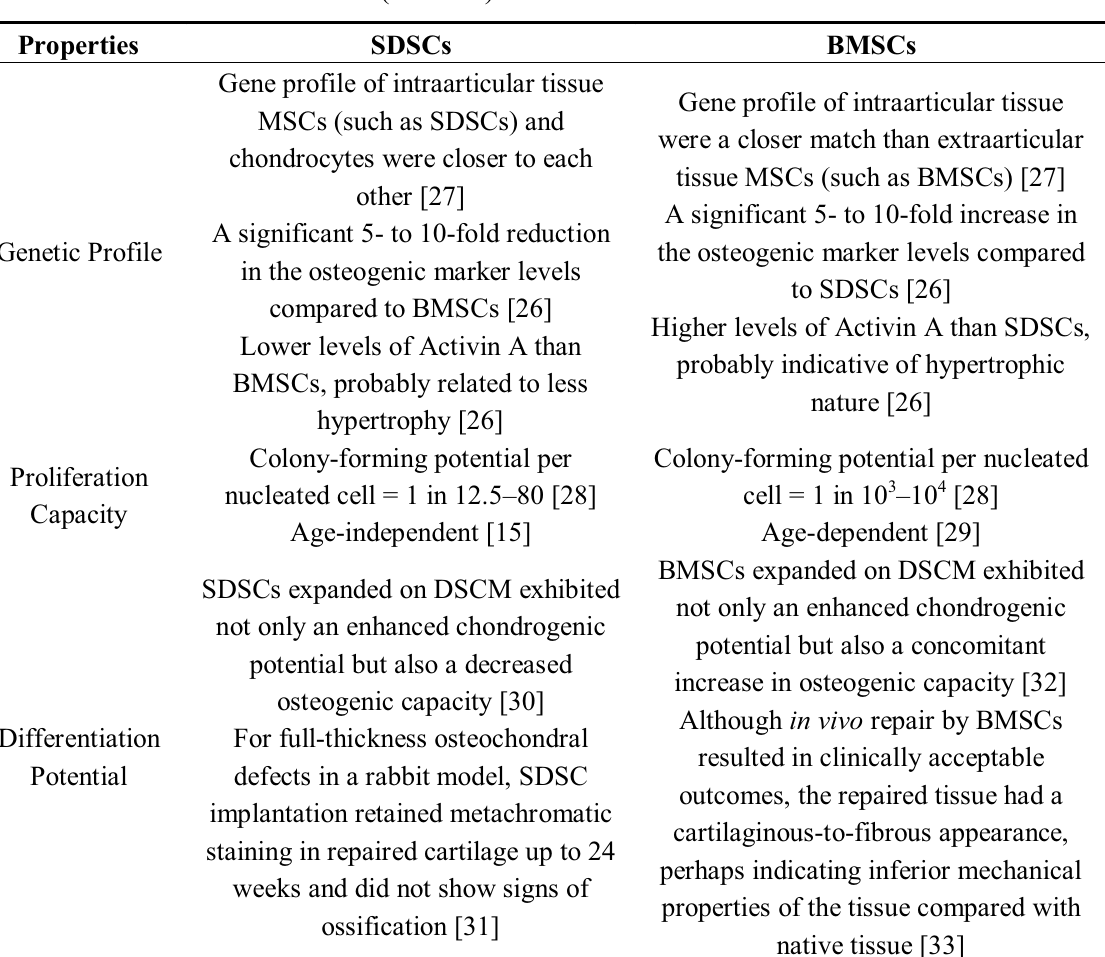
Table 1. Difference in cell properties between synovium-derived stem cell (SDSCs) and bone marrow derived stem cells